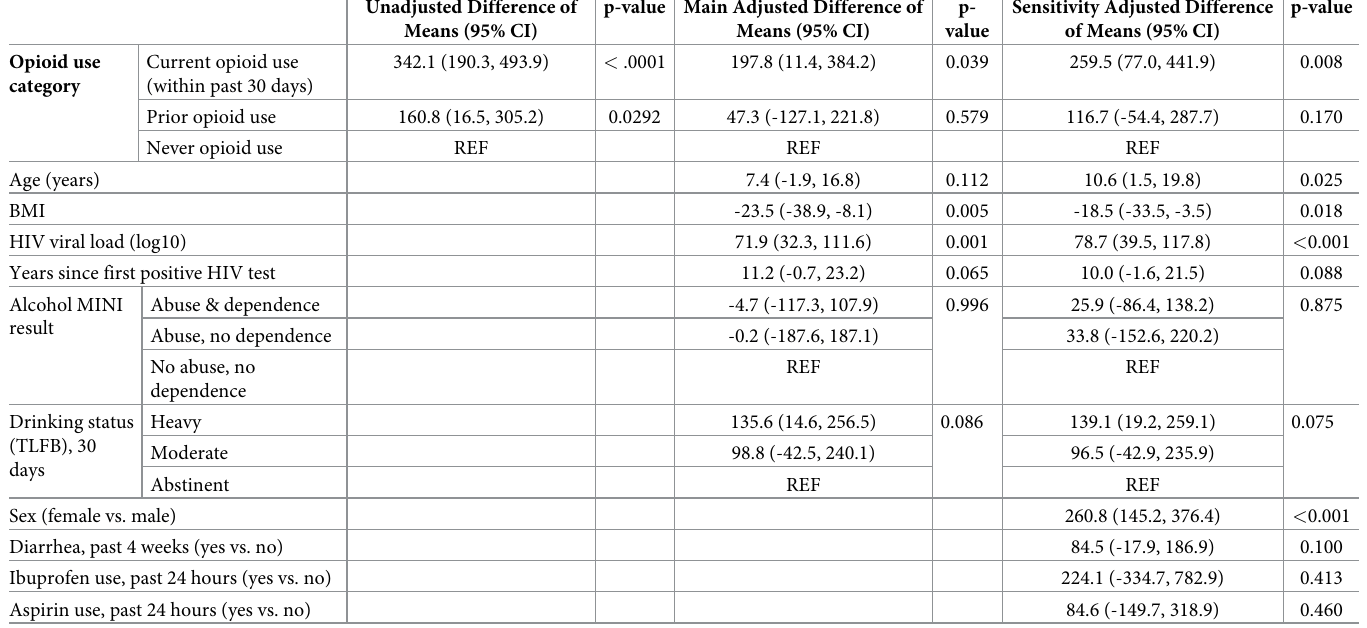
Table 2. Unadjusted and adjusted difference of means and 95% Confidence Intervals (CI) for the association between opioid use category and plasma concentration of sCD14 among a cohort of Russia PLWH (N = 344).